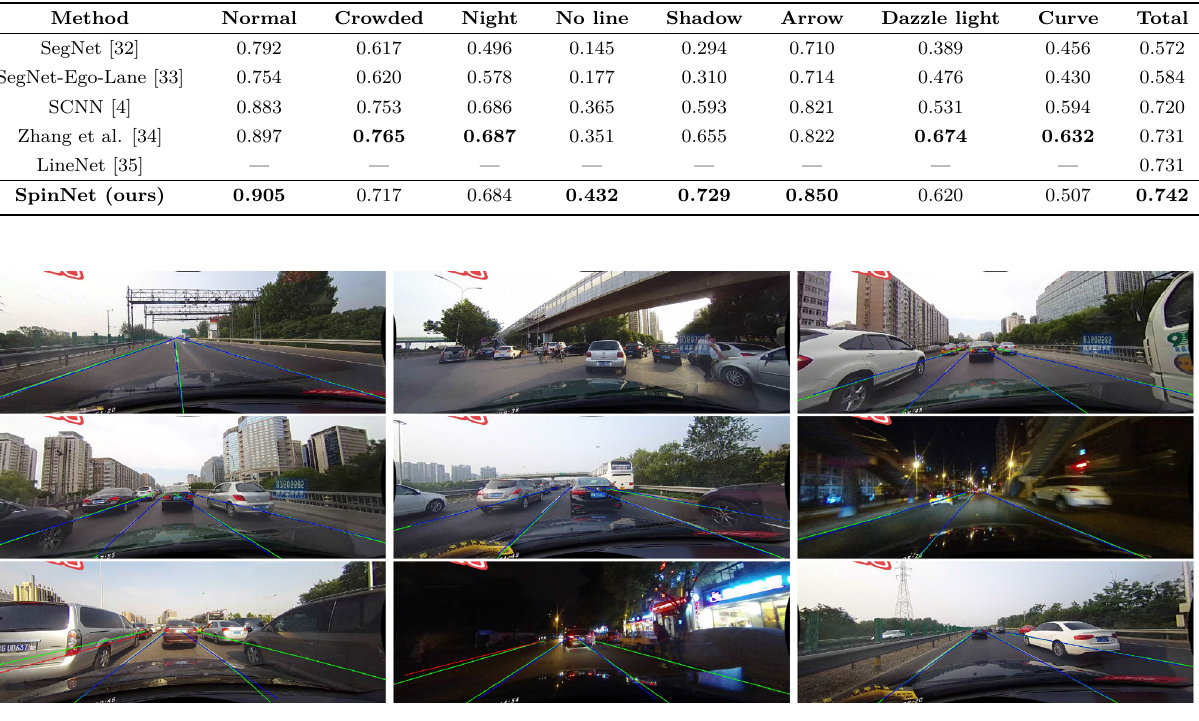
Fig. 4 Selected examples produced by our SpinNet. Green lines are the ground truths. Blue lines are the predicted true positive line boundaries, while red lines are the incorrect prediction results. From this figure, we can see that our framework works well even in crowded road with obvious occlusion and scenes with low